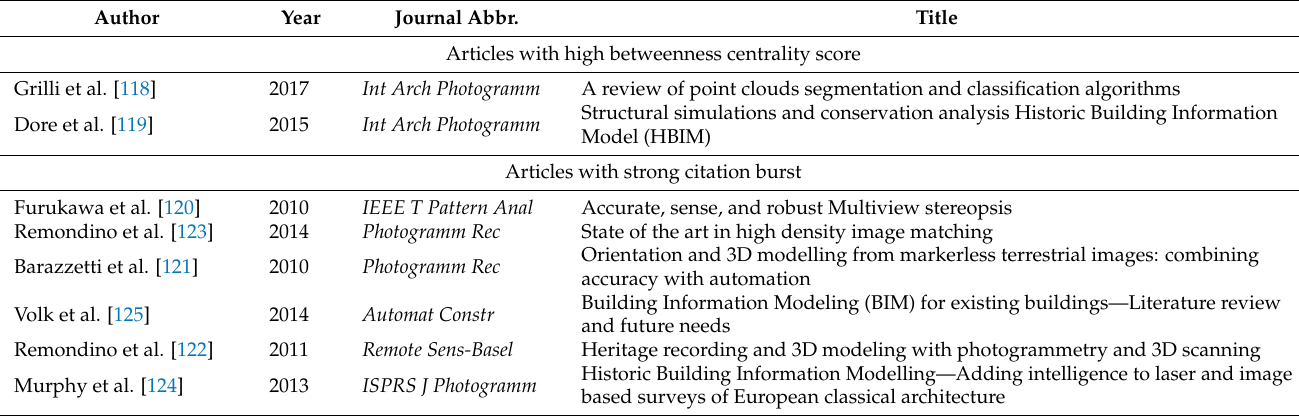
Table 3. Landmark articles in the document co-citation network analysis.